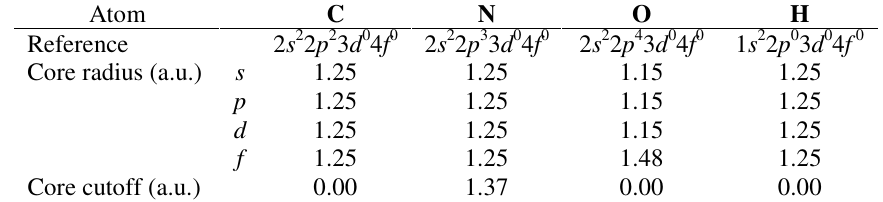
Table 1. Reference configuration and cut-off radii (a.u.) of the pseudopotentials used in this study. Atom C N O H